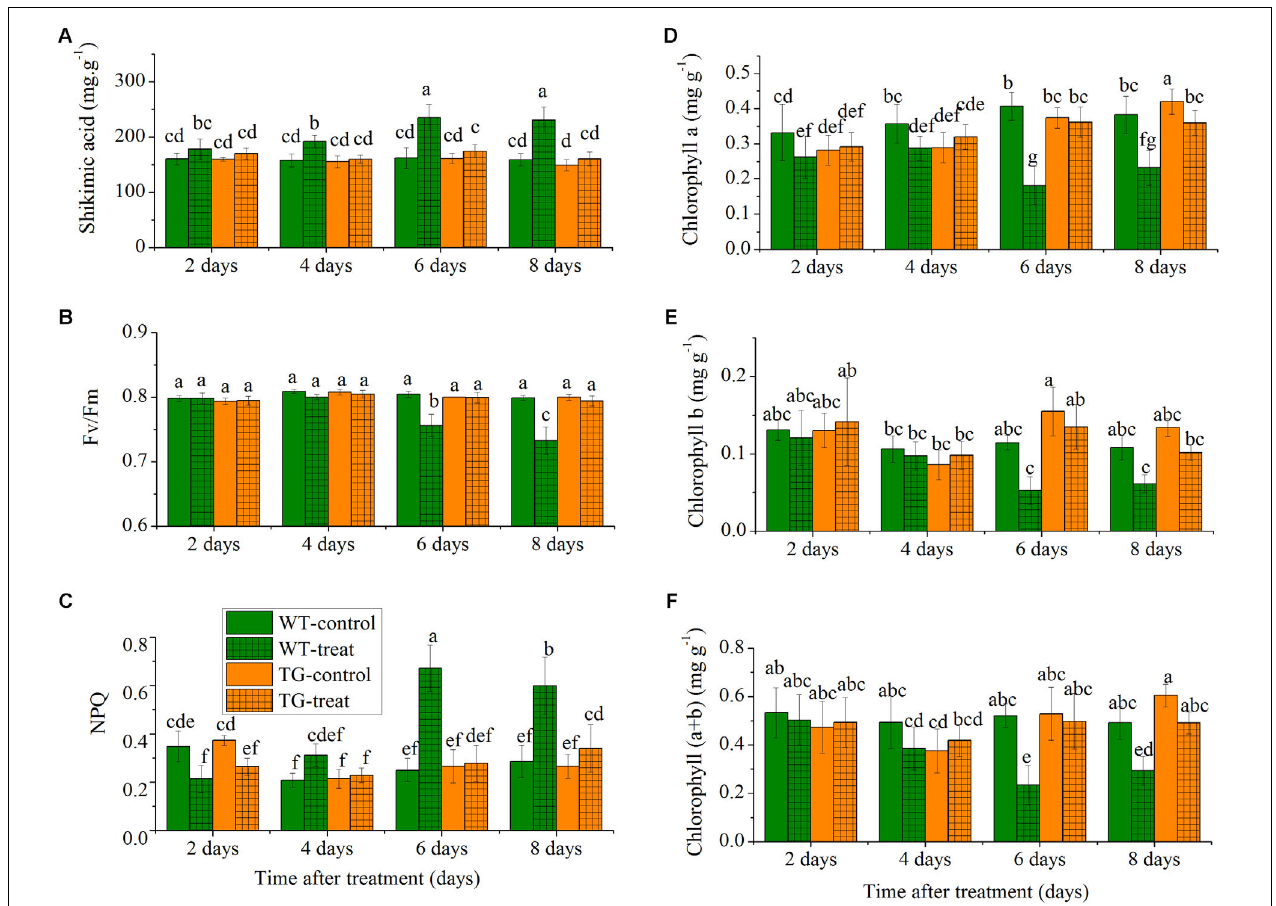
FIGURE 3 | Time-course effect of glyphosate on the responses of leaf shikimic acid concentration (A) , F v /F m (B) , NPQ (C) , chlorophyll a (D) , chlorophyll b (E), and chlorophyll (a+b) content (F) in WT and TG maize plants. Values are presented as the means plus error bars, where the error bars represent the SD of the mean. Within a graph, any two bars with a common letter are not statistically significant ( P >